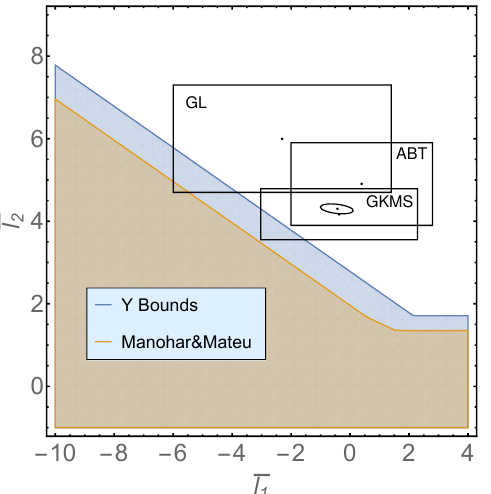
Figure 5 . Comparison of our positivity bounds on (cid:22) l 1 and (cid:22) l 2 with those of Manohar and Mateu [18] for the (cid:25)(cid:25) scattering to one loop. See eqs. (4.4) to (4.9) for the error estimates for these bounds. The rectangles GL, ABT, GKMS and the small ellipse inside it are the ranges of the (cid:12)tted values of (cid:22) l 1 and (cid:22) l 2 given in refs. [3, 72, 73] and [71]